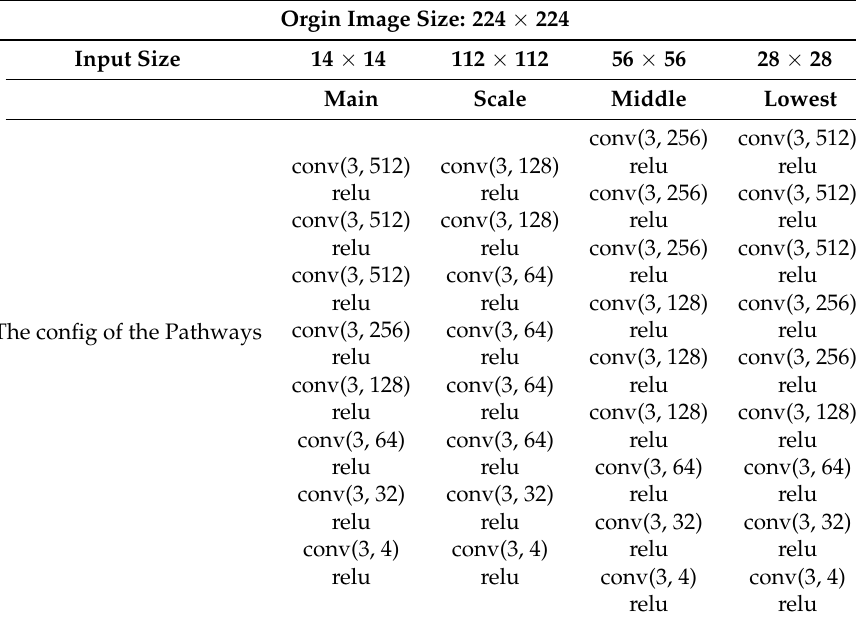
Table 2. The config of the